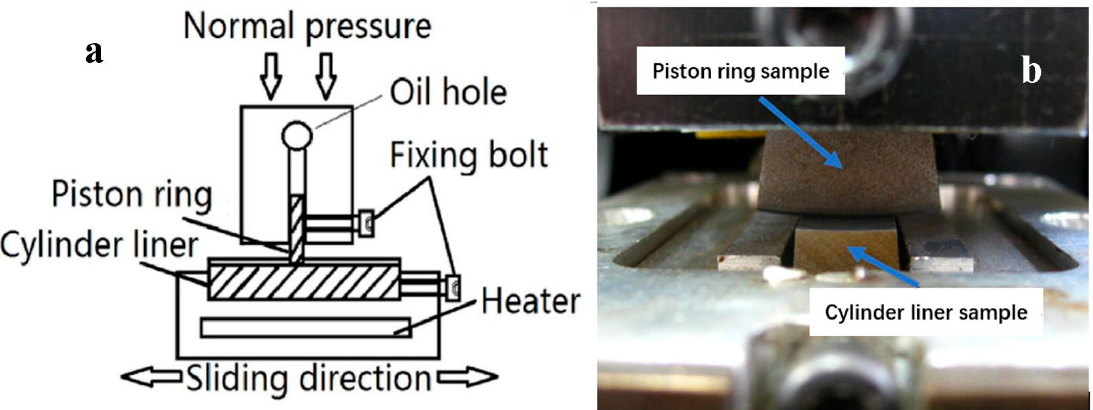
Figure 2. Detailed layout of piston ring and cylinder liner ( a ) and the PRCL contact along the circumferential direction ( b ).